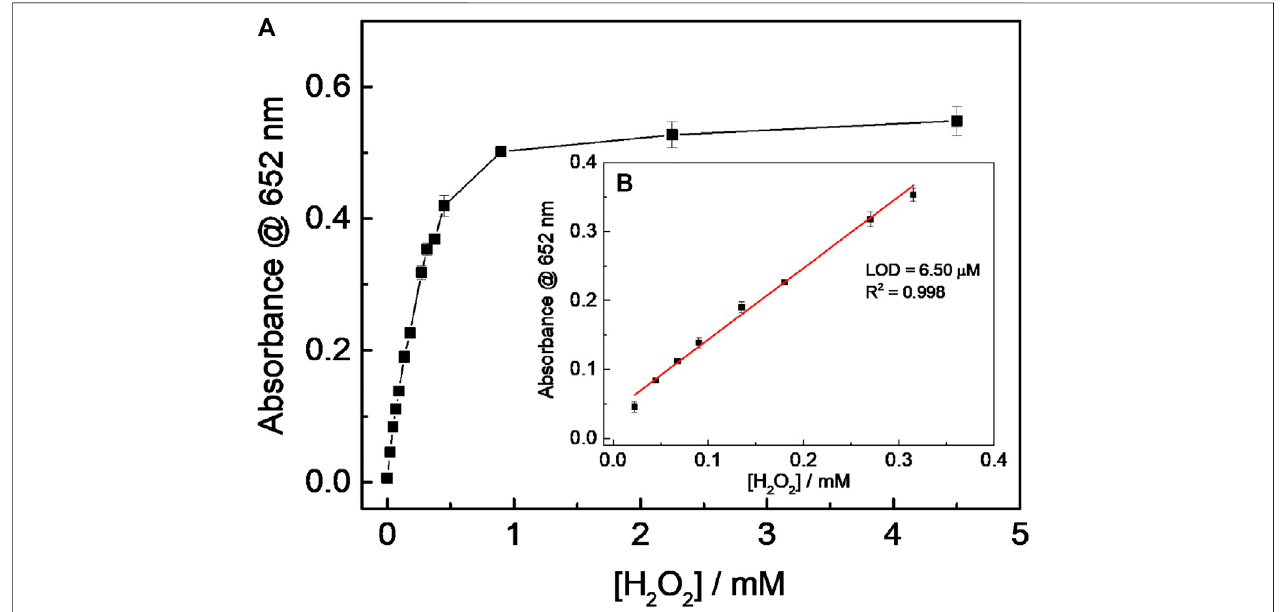
FIGURE 8 | (A) Relationship between absorbance at 652 nm and (H 2 O 2 ); (B) linear fi tting curve for (H 2 O 2 ) and absorbance at 652 nm. (Inset: pictures were taken 15 min after adding CD-phenylalanine to the solution containing TMB and H 2 O 2 ).